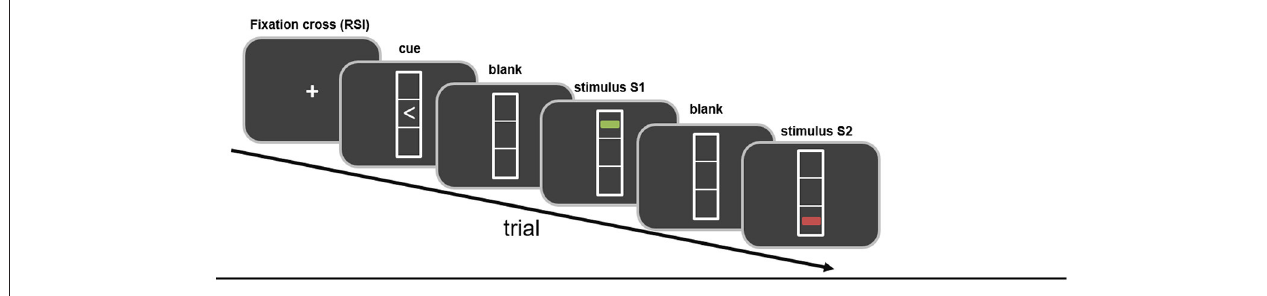
FIGURE 1 | Schematic illustration of the paradigm. Stimuli and their temporal sequence are shown. Further details are given in the main body of the